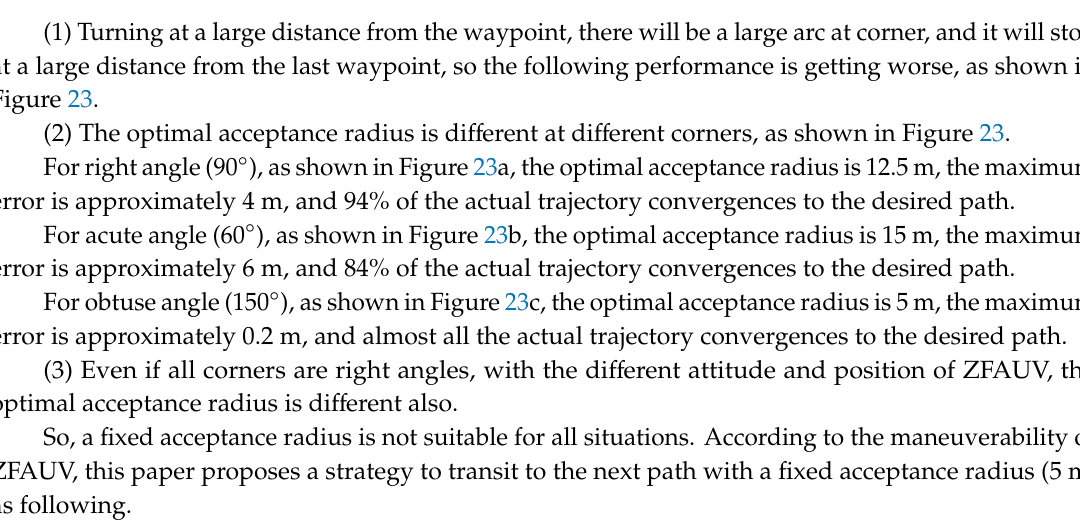
Figure 23. Simulation results with different acceptance radius.